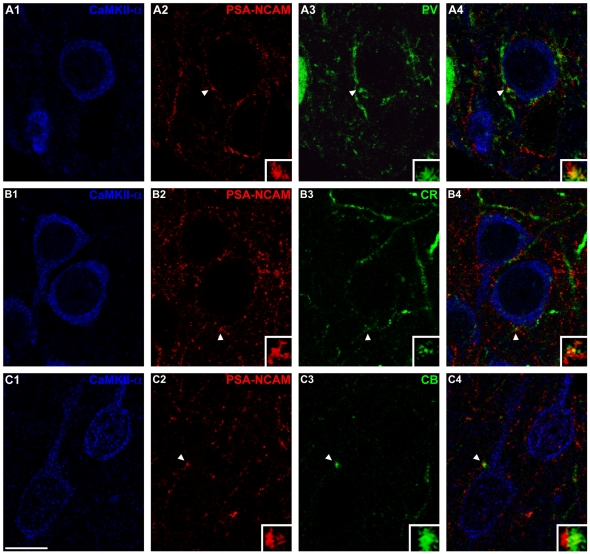
Confocal microscopic analysis of the co-expression of PV, CR and CB in PSA-NCAM immunoreactive puncta surrounding pyramidal cell somata in mPFC.(A) PSA-NCAM-expressing puncta co-expressing with PV in the perisomatic region of a neuron expressing CaMKII-α. (B) PSA-NCAM immunoreactive puncta co-expressing CR surrounding CaMKII-α expressing neurons. (C) Observe a CB-expressing puncta close to a PSA-NCAM expressing puncta in the perisomatic region of a pyramidal neuron. All the images in this figure are taken from single confocal planes. Scale bar: 10 µm. Insets in the images are 5× enlargements of puncta marked with arrowheads.